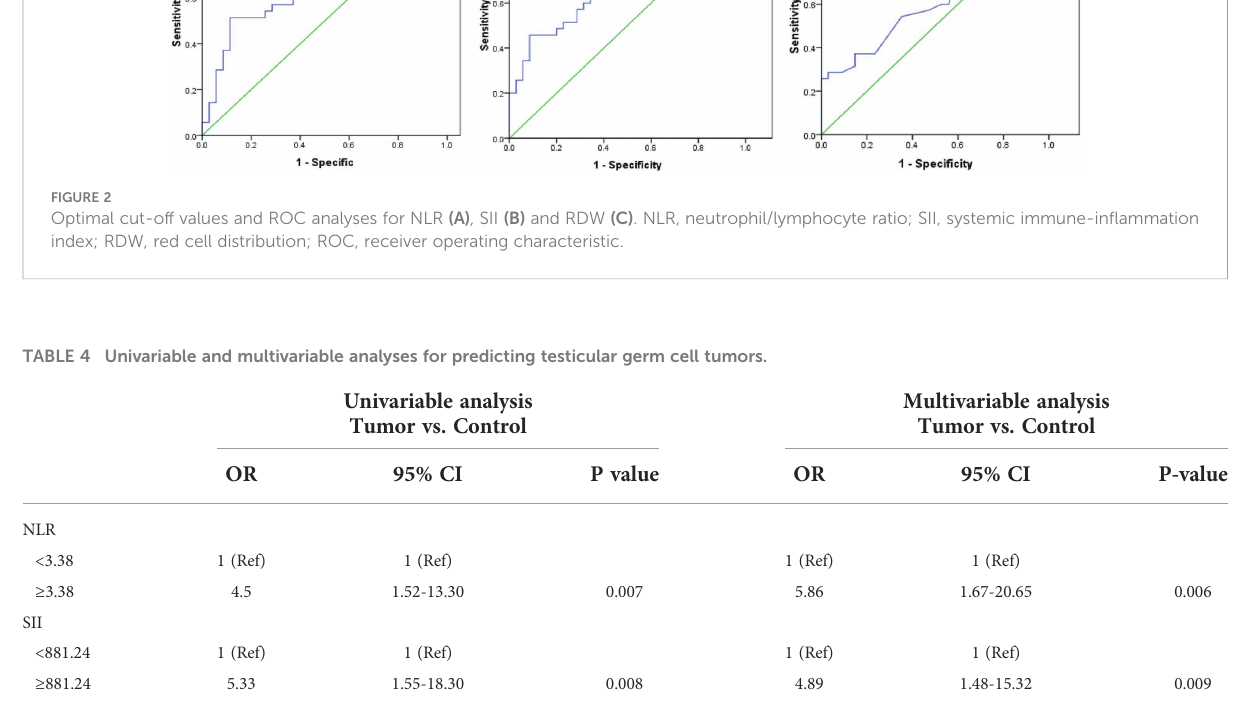
TABLE 5 Comparison of CBC based parameters between sTGCT and nsTGCT.